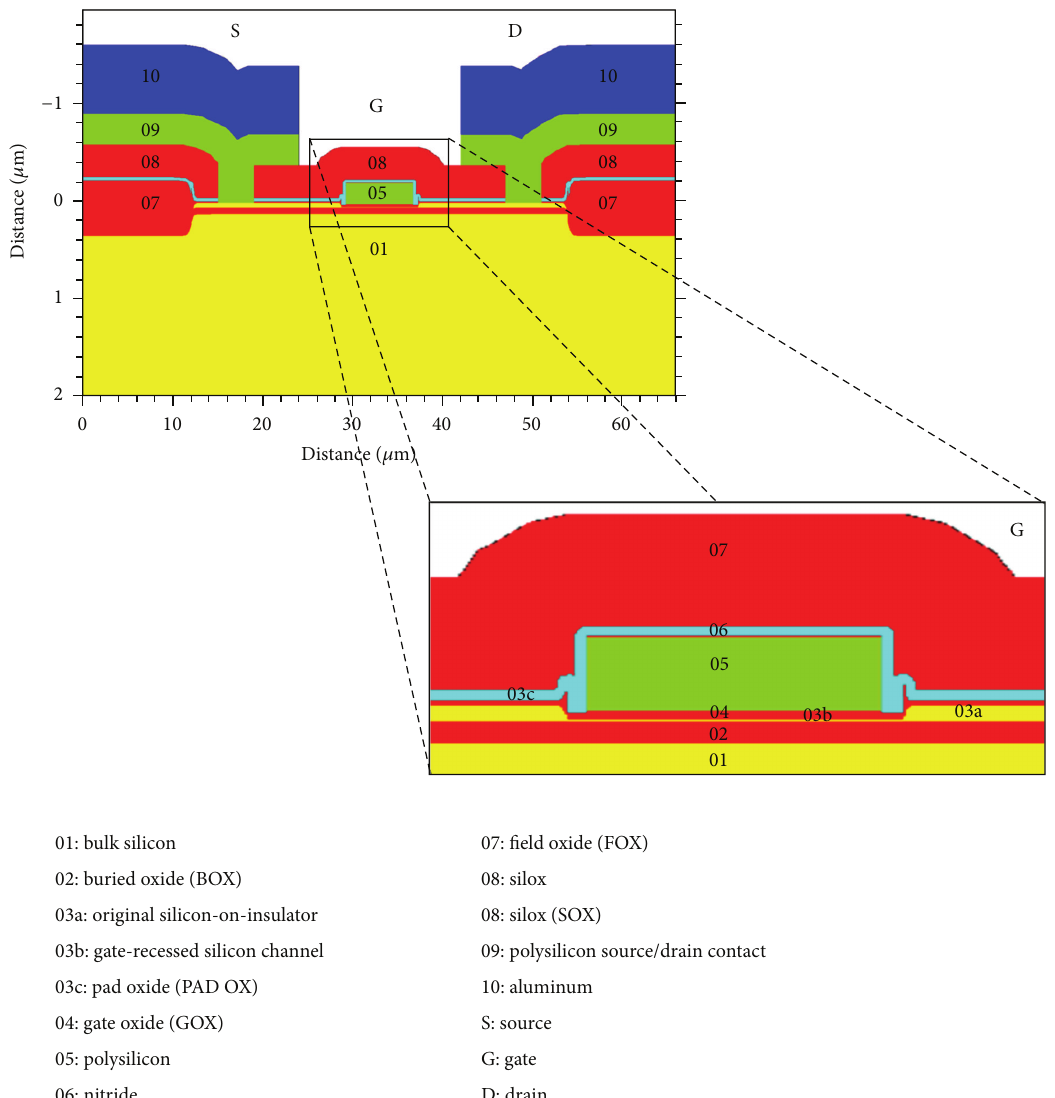
Figure 3: Cross-view of a TCAD (Tsuprem4) simulated nanoscale devices using the gate-recessed channel process. The layers deposition sequence is described in the